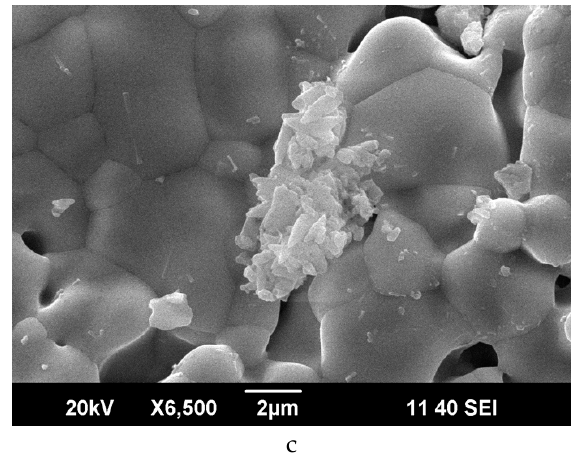
Figure 3. SEM images of ( a ) Sm 2 Zr 2 O 7 ceramics; ( b ) Sm 1.9 Ca 0.1 Zr 2 O 6.95 ceramics; ( c ) the micron-size agglomerate formed from small grains in Sm 1.9 Ca 0.1 Zr 2 O 6.95 ceramics.